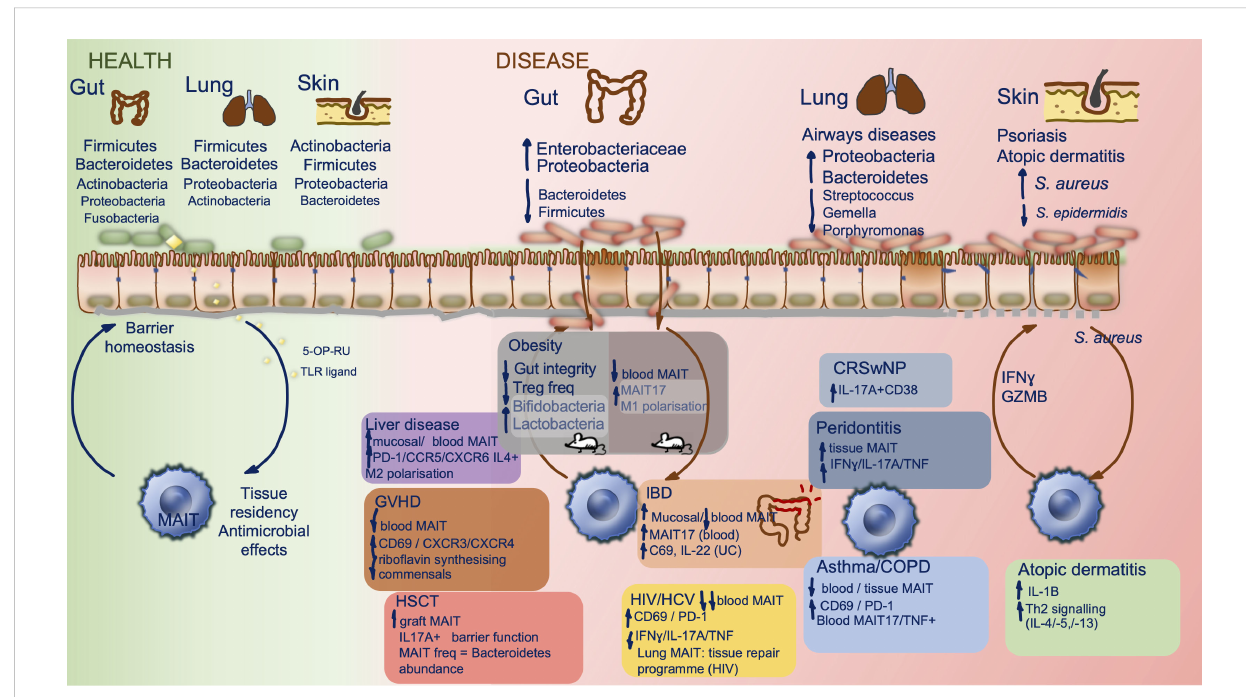
FIGURE 2 MAIT cells and the microbiome in health and disease. Constituents of the human microbiome in health, at different barrier sites, and interactions with tissue resident MAIT cells are shown (left). Key compositional shifts in human microbiota and their resultant effects in a range of disease states are summarized by barrier site (right), data are derived from human studies except within obesity where mouse studies have been included and highlighted within the fi gure. There is relative paucity of data on direct MAIT cell effect on the microbiome. CRSwNP, chronic rhinosinusitis with nasal polyposis; COPD, chronic obstructive pulmonary disease; GVHD, graft versus host disease; HSCT, hematopoietic stem cell transplant; HCV, hepatitis C virus; HIV, human immunode fi ciency virus; IBD, in fl ammatory bowel